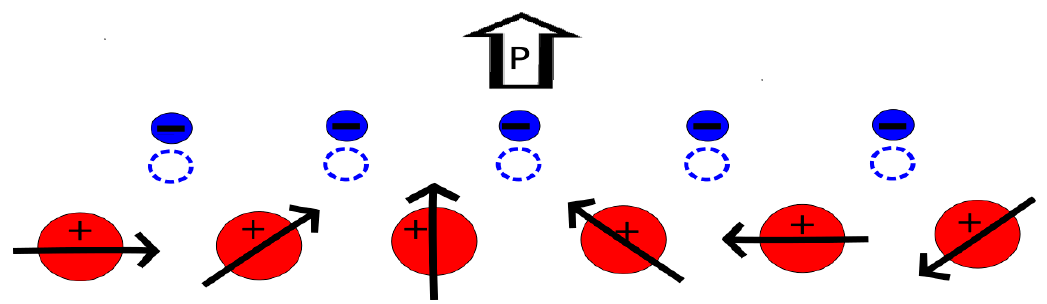
Figure 4. Mn 3+ (red) spiral spin order will induce with the exchange striction a uniform displacement of the O 2 − (blue) that breaks the space inversion symmetry and thus, induces a net electric polarization (P).